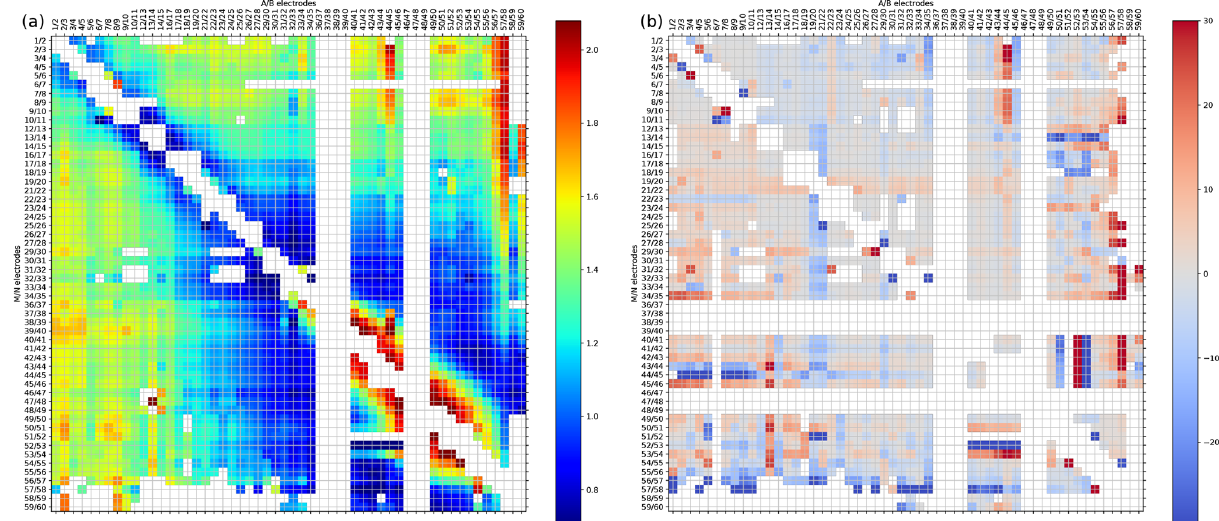
Figure 4. Raw data (all retrieved AB–MN pairs) as a function of current AB and potential MN dipoles. (a) Apparent resistivity (log ρ a ; (cid:127) m) and (b) relative reciprocal error between forward (starting with current dipole 1 / 2) and reverse measurements (%).